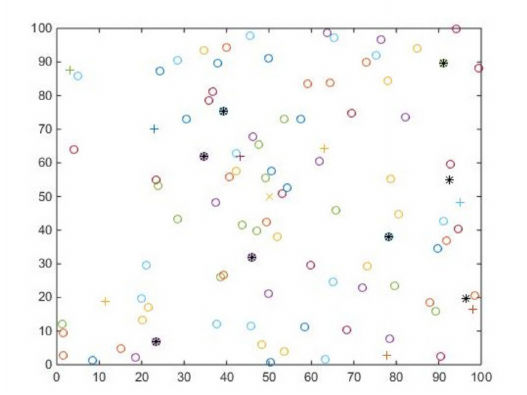
Figure 23. Improved nodes under the LEACH